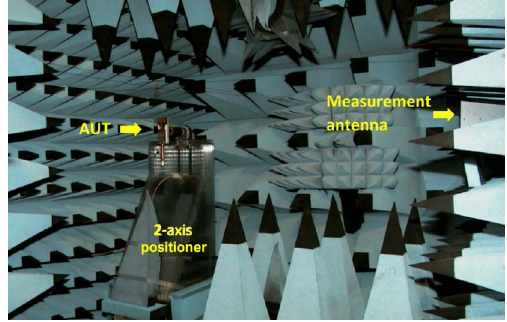
Figure 10. Antenna measurement setup in anechoic chamber.